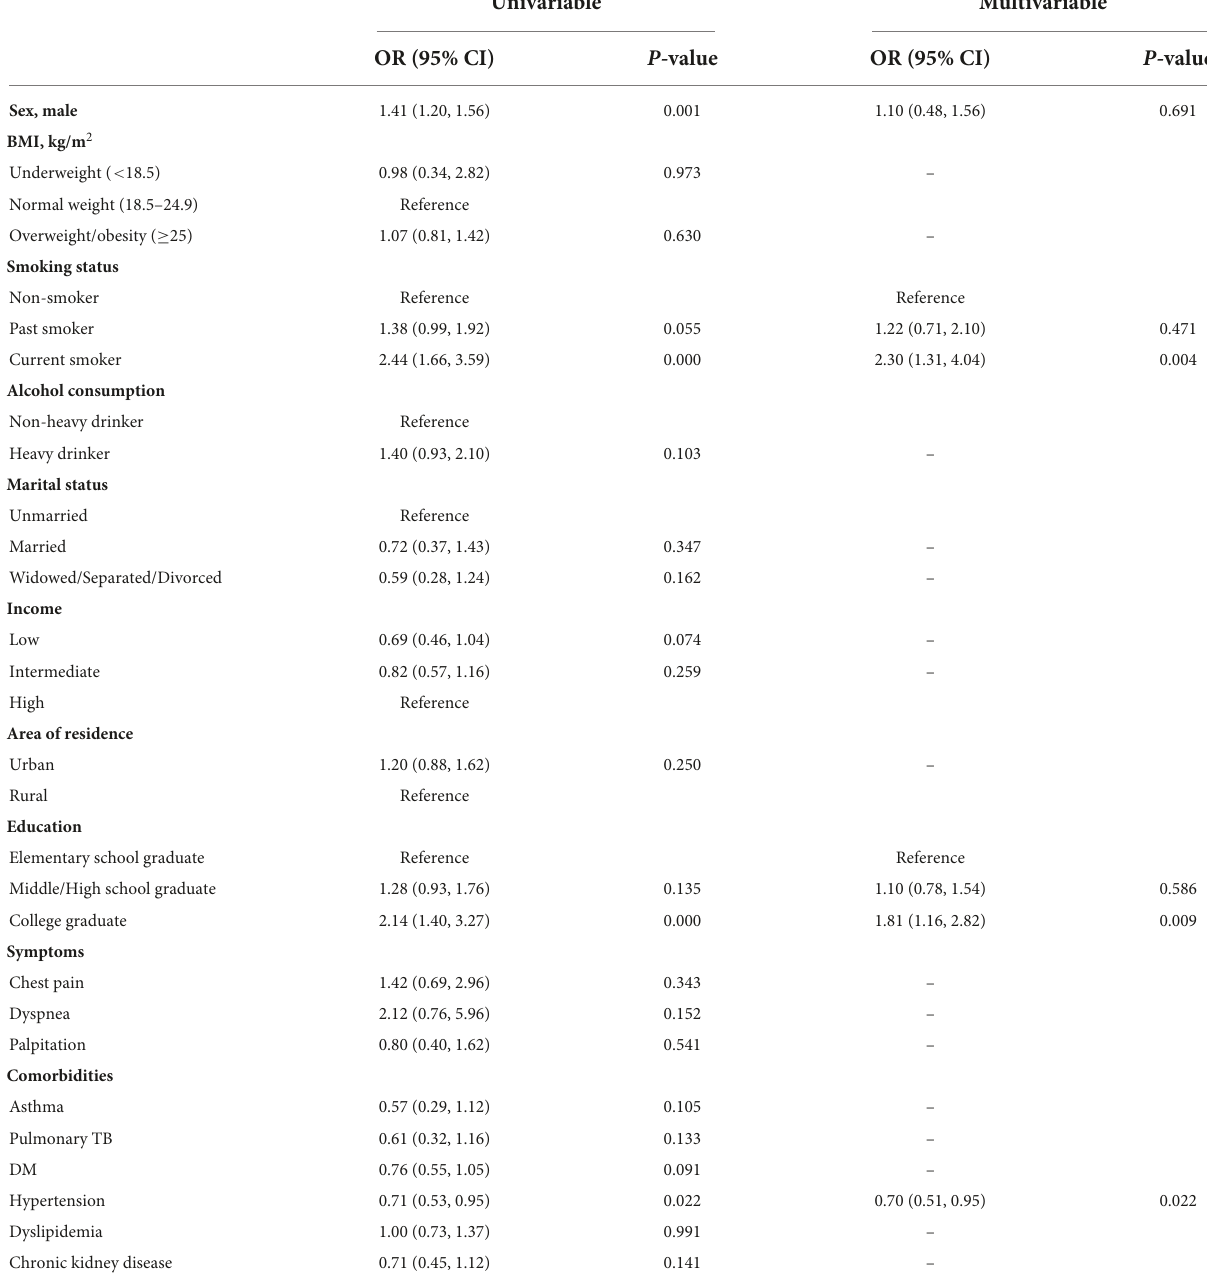
TABLE 3 Factors associated with influenza unvaccinated status in patients aged < 65 years with cardiovascular